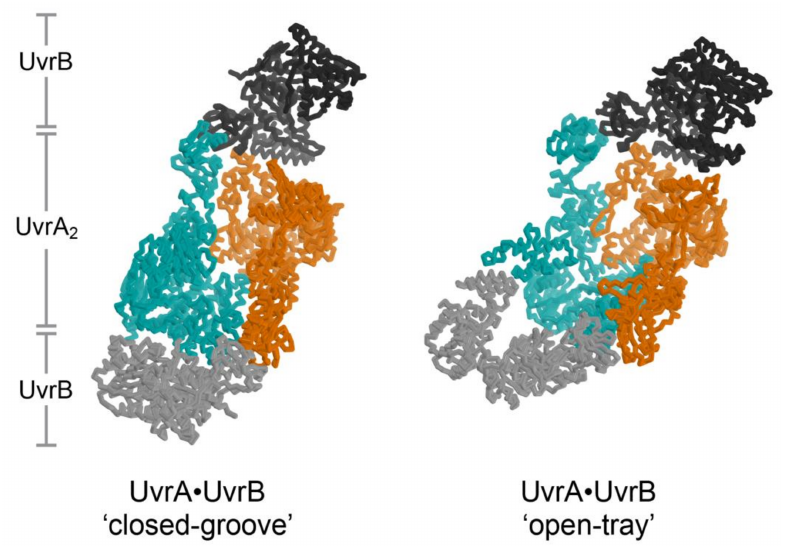
Figure 3. Two models for the UvrA 2 B 2 complex. The two UvrA protomers are shown in cyan and orange, while the two UvrB molecules are shown in different shades of gray. The crystal structure of the UvrA 2 B 2 complex has the UvrA dimer in the ‘closed-grooved’ configuration [22] ( left ), whereas the negative stained electron microscopy structure of UvrA 2 B 2 complex in the presence of DNA has the UvrA dimer in the ‘open-tray’ configuration ( right ) [21]. Although dsDNA was included in the EM sample, the DNA is not visible in the electron density map and is not included in the model. The two UvrA 2 B 2 models are aligned on the orange UvrA protomer. With this alignment the cyan UvrA protomers in the two models are related by a 50 ◦ helical rotation (50 ◦ rotation, 20 Å translation) about the axis approximately parallel to the presumed DNA binding